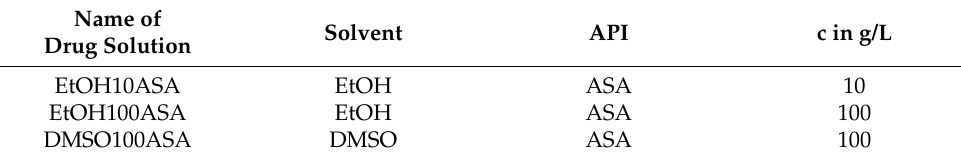
Table 1. Overview and details of the investigated drug